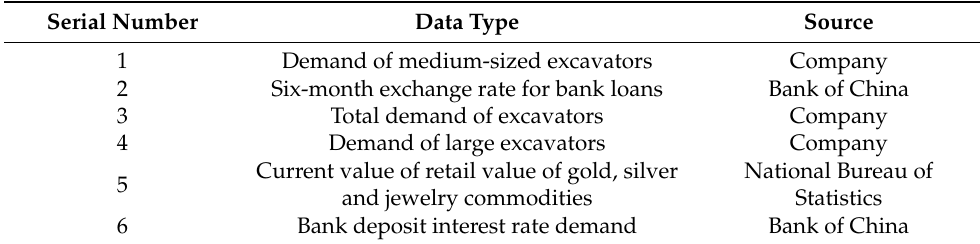
Figure 2. Feature dimension reduction based on decomposed synthetic RFE. Table 2. Factors after screening (large type).